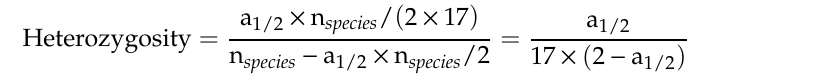
Figure S1: Top-hit species distribution of top 64 longest scaffolds (all > 62 kb) from in vivo M. cordata , Figure S2: scaffold assembly evaluation, Table S1: top 100 species distribution of contigs in each stray region from NT blast results. Author Contributions: Conceptualization, supervision, and funding acquisition, Y.S. and T.W.; methodology and resources, X.H. and C.L.; validation and investigation, Y.H. and X.R.; formal analysis, data